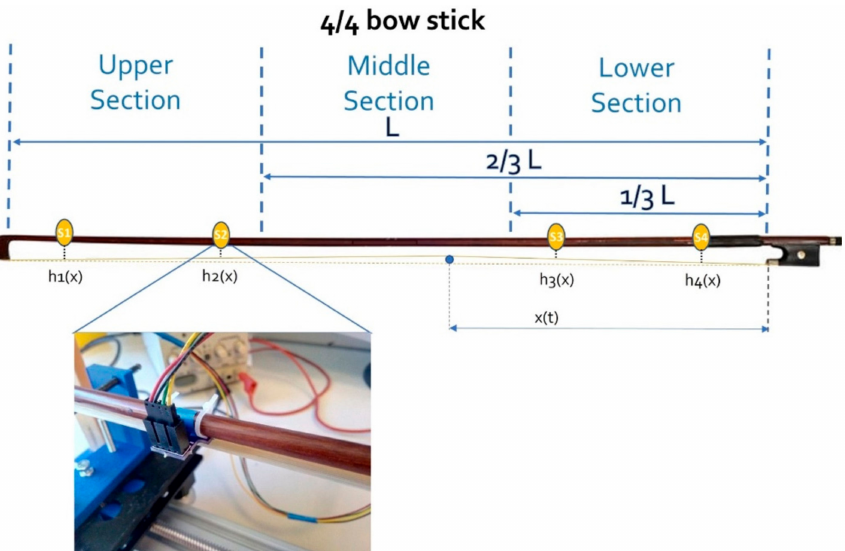
Figure 2. Sections of the bow and position of the optical sensors (see Section 2.2). The sensors from S4 to S1 are placed, respectively, about L/14, 3/13 L, 3/4 L, and 24/25 L from the frog using a cable tie (see the detailed view reported for sensor S2). The blue dot represents the section of the string in contact with the bow hair. Sensor outcomes depend on the position (x(t)) of the contact